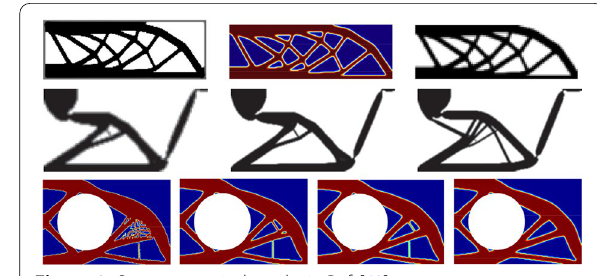
Figure 2 Some numerical results in Ref. [67] Figure 3 Some numerical results in Ref. [68]